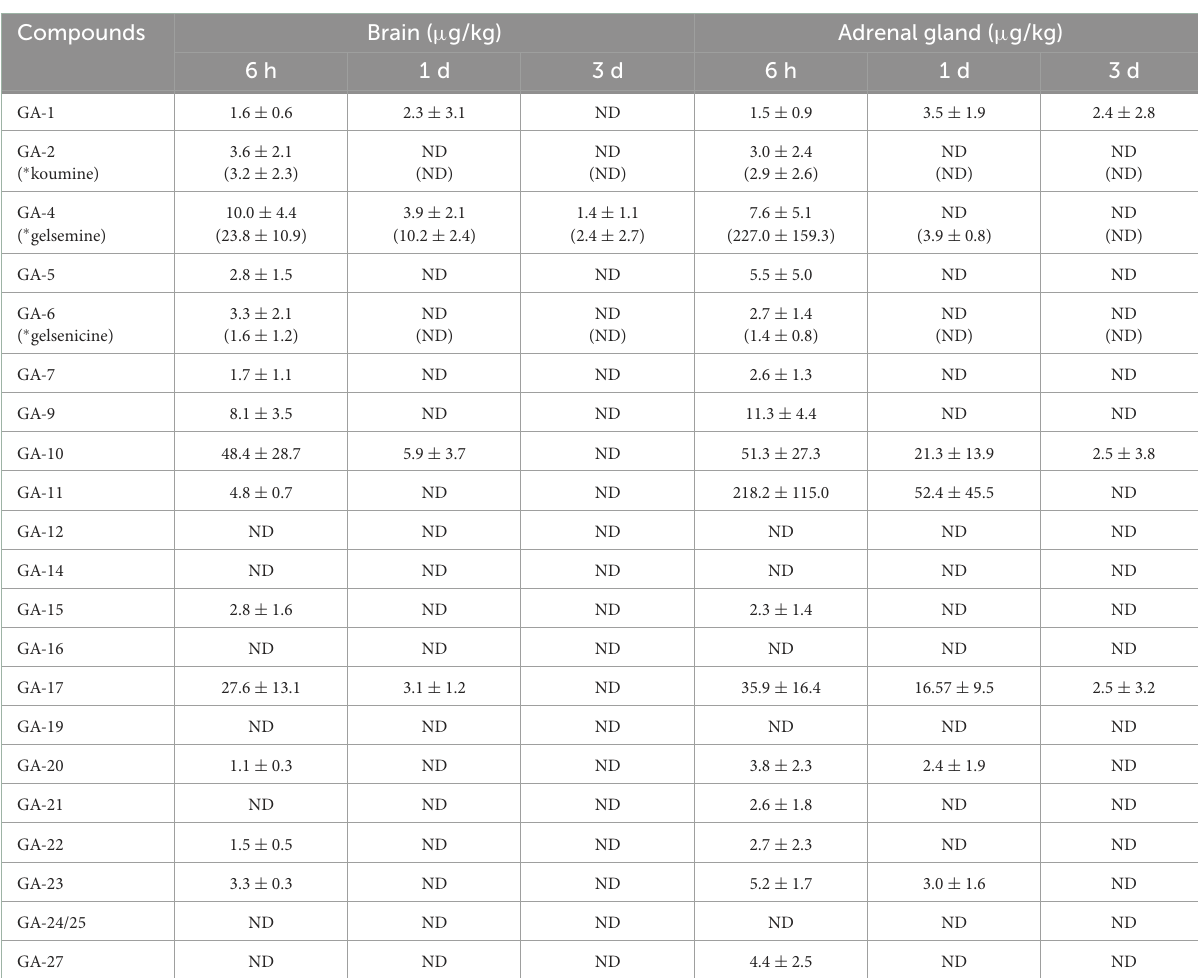
TABLE 4 Concentrations of Gelsemium alkaloids in pig brain and adrenal gland after 45 d of consecutive administered G. elegans powder at a dose of 2% per kilogram feed ( µ g/kg) ( n = 5).